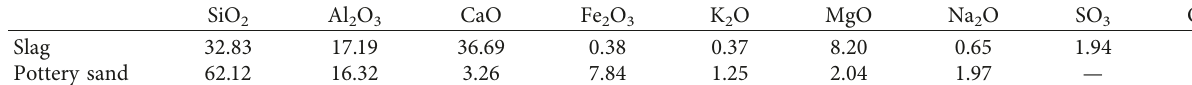
Table 1: Chemical composition (%) of slag and pottery sand.